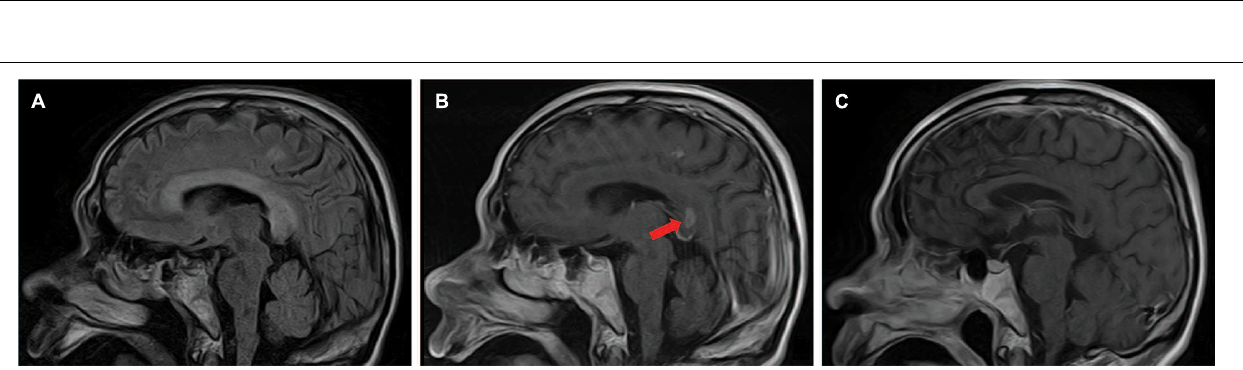
FIGURE 2 | Sagittal images of brain MRI performed 7 days (A,B) and 22 days (C) after onset. MRI performed 7 days after onset revealed hyperintense lesions on T2-weighted imaging throughout the entire CC and in some extracallosal regions (A) . Lesions that were enhanced by gadolinium could be seen in the splenium (arrow) and some extracallosal regions (B) . Follow-up head MRI performed 22 days after onset showed necrosis without enhancement had occurred in the formerly gadolinium-enhanced lesions (C) .